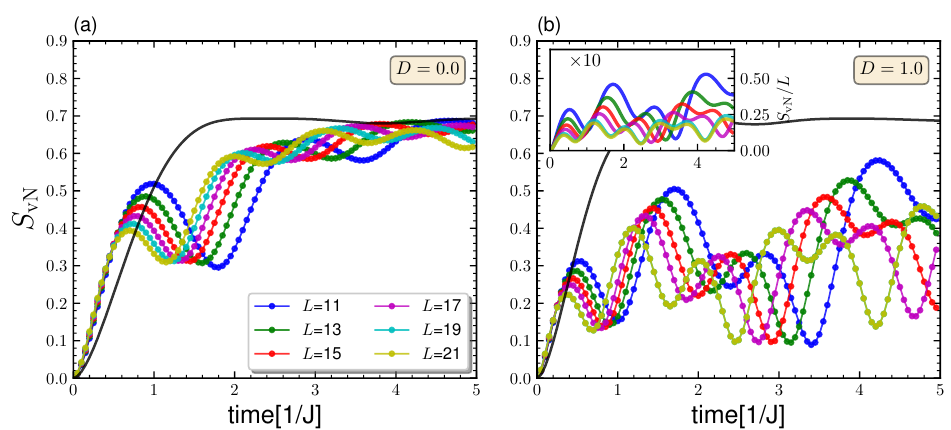
Figure 9: (colour online) Growth of half-chain entanglement entropy S tonian Eq.(1) with ∆ = 0.5 for various different chain length at long-range regime with α = 0.5. Where DM interaction (a) D = 0.0, (b) D = 1.0. The solid-black line is data for nearest-neighbour case ( α → ∞ ). Inset shows S